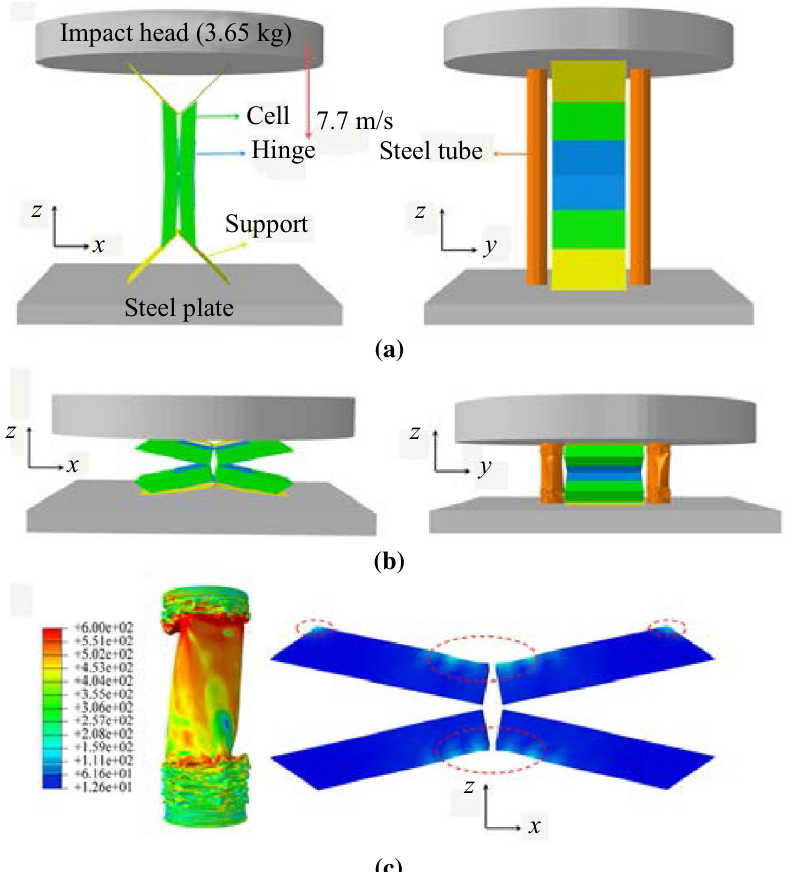
Fig. 2 Computer simulation of battery module a before and b after impact; c stress distribution in the battery module at 10 ms during